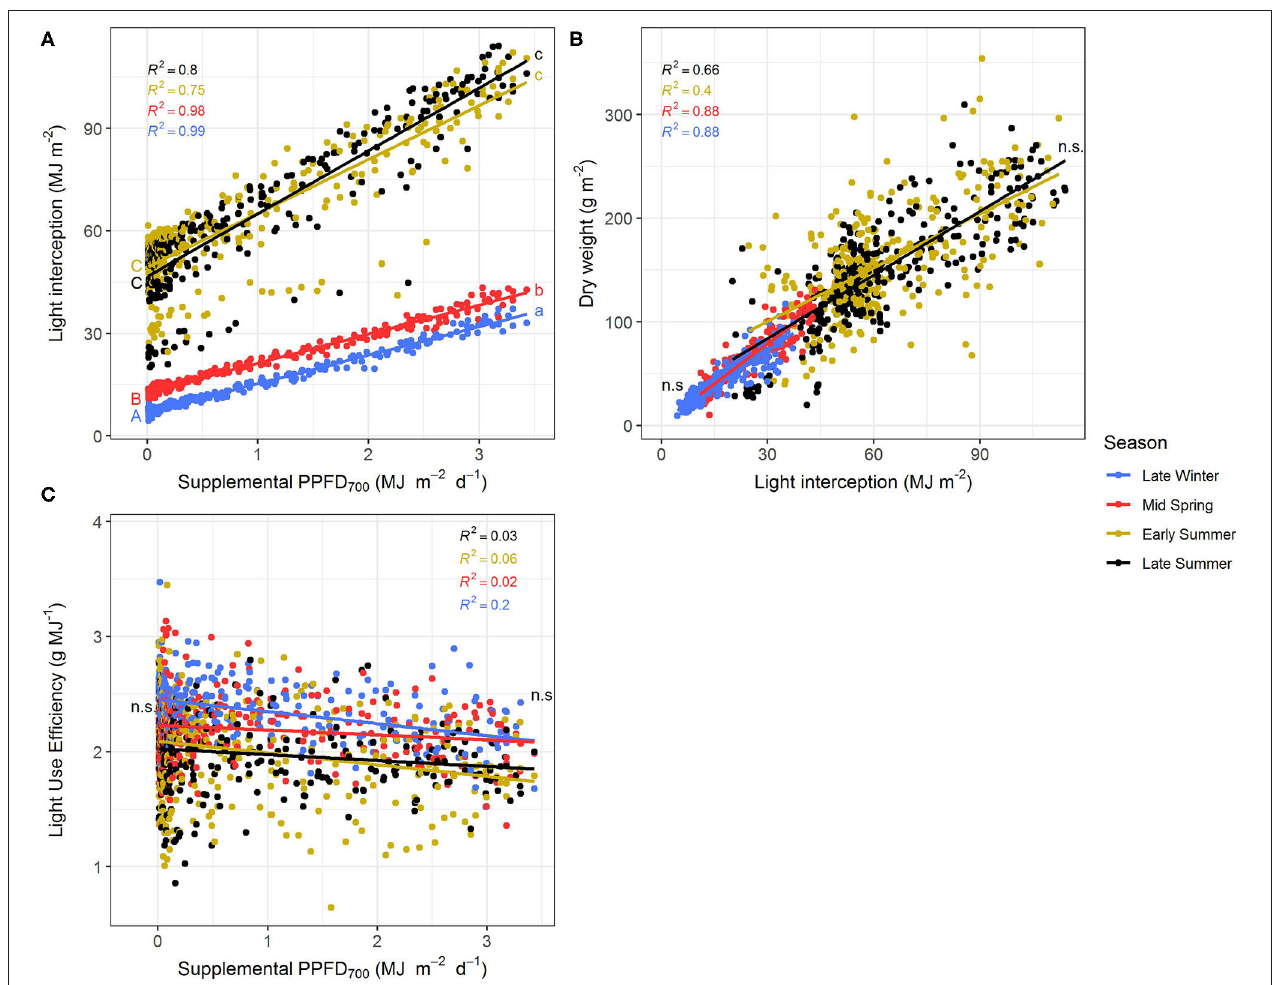
FIGURE 6 | Effect of the season on light interception (A) , dry weight (B) , and light use efficiency (C) of Ocimum basilicum L. cv. “Edwina” cultivated under greenhouse conditions. Different lower-case and upper-case letters indicate significant differences in slopes and intercepts between seasons ( p < 0.05; n.s., non-significant), respectively. Linear regression lines of each light color are indicated. Regressions are based on 120 plants per treatment, each with a specific light dose. Each data point shows an average of the three light colors, two harvest points, and two experimental